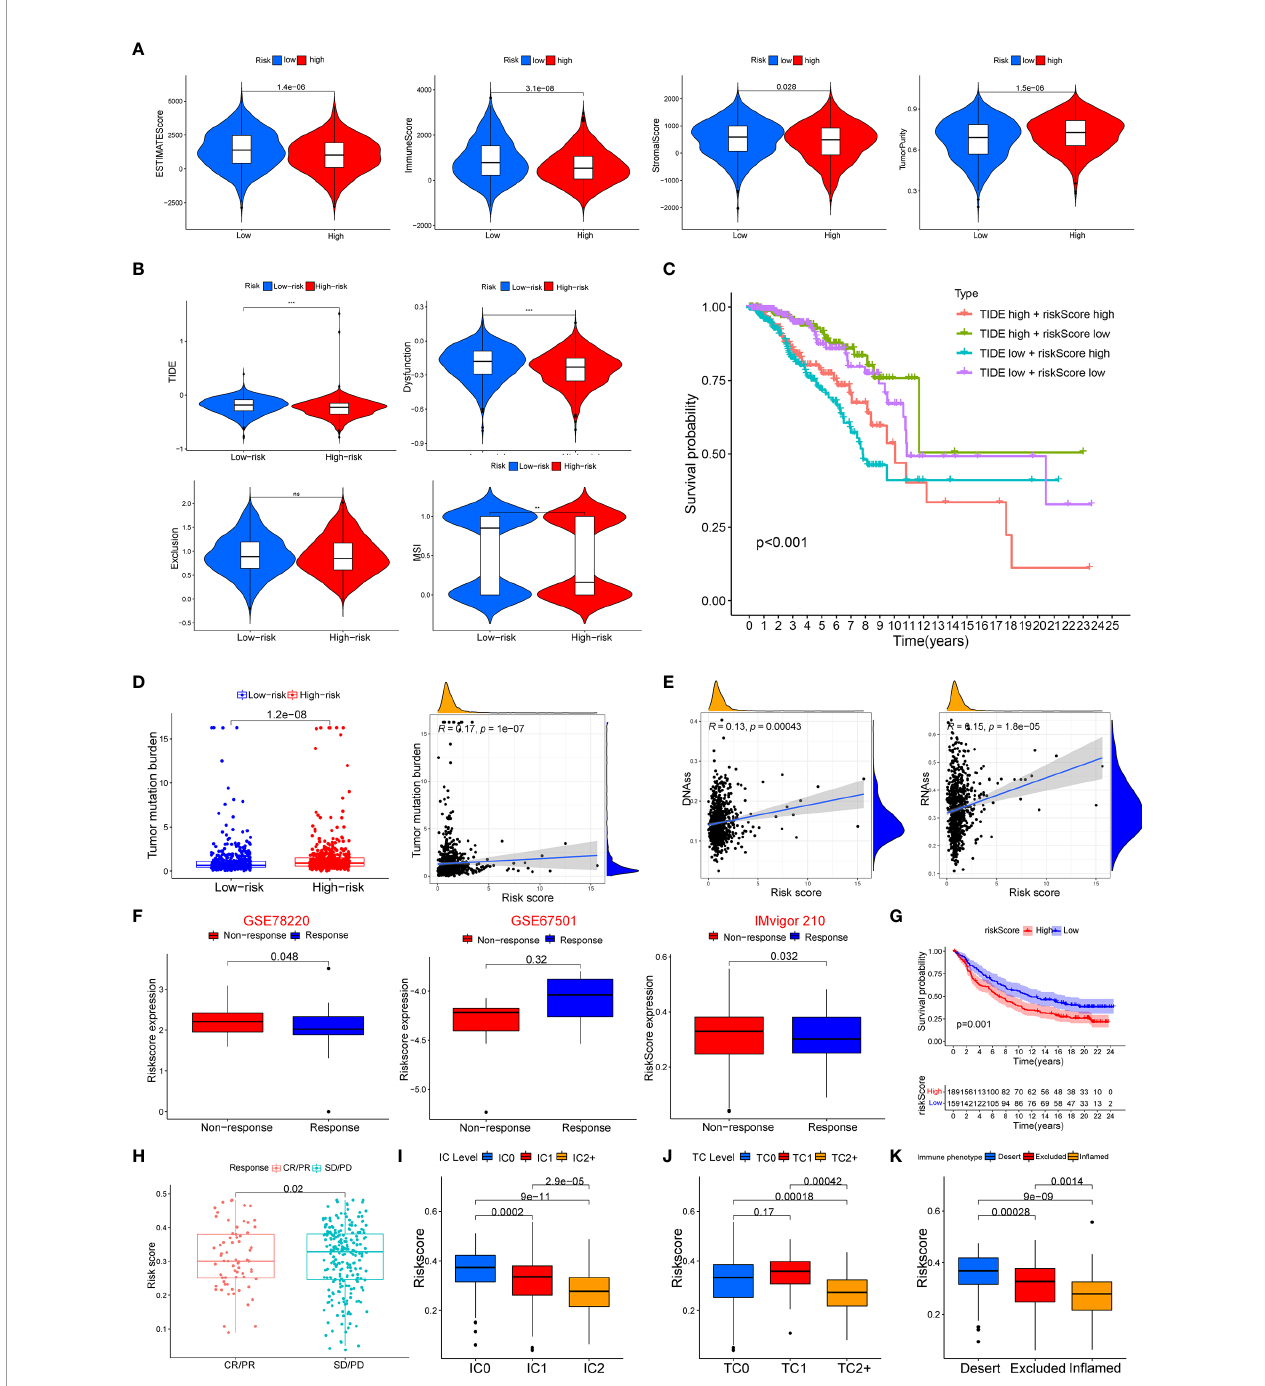
FIGURE 9 | Association between the risk score with tumor microenvironment and response to immune checkpoint inhibitors. (A) Association of risk score and tumor microenvironment. (B) Relationship of risk score and dysfunction, TIDE, exclusion, and MSI. (C) KM survival curve analysis of patients with different combinations of risk scores and TIDE in TCGA cohort. (D) Association of the risk score with tumor mutation boundary. (E) Relationship of the risk score with RNAss and DNAss. (F) The risk score of patients responding or not responding to anti-PD-1/PD-L1 in GSE78220, GSE6750, and IMvigor210 cohorts. (G) KM curve in IMvigor210 cohort. (H) Association of the risk score with clinical response diagnosis. (I – K) Correlation of risk score with immune phenotype and PD-L1 expression on immune cells and tumor cells. TIDE, Tumor Immune Dysfunction and Exclusion; MSI, microsatellite instability; KM, Kaplan – Meier; TCGA, The Cancer Genome Atlas. **p < 0.01, ***p < 0.001. ns, no signi fi